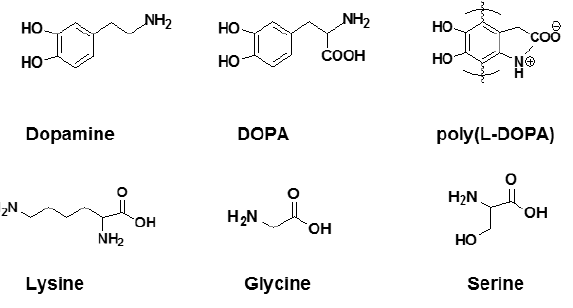
Figure 8. Chemical structure of dopamine, 3,4-dihydroxyphenylalanine (DOPA) [1], poly(3-(3,4-dihydroxyphenyl)- L -alanine) (poly( L -DOPA)) [56], lysine, glycine and serine [57]. As a PDA-like compound, 3-(3,4-dihydroxyphenyl)- L -alanine ( L -DOPA, as shown in Figure 8)